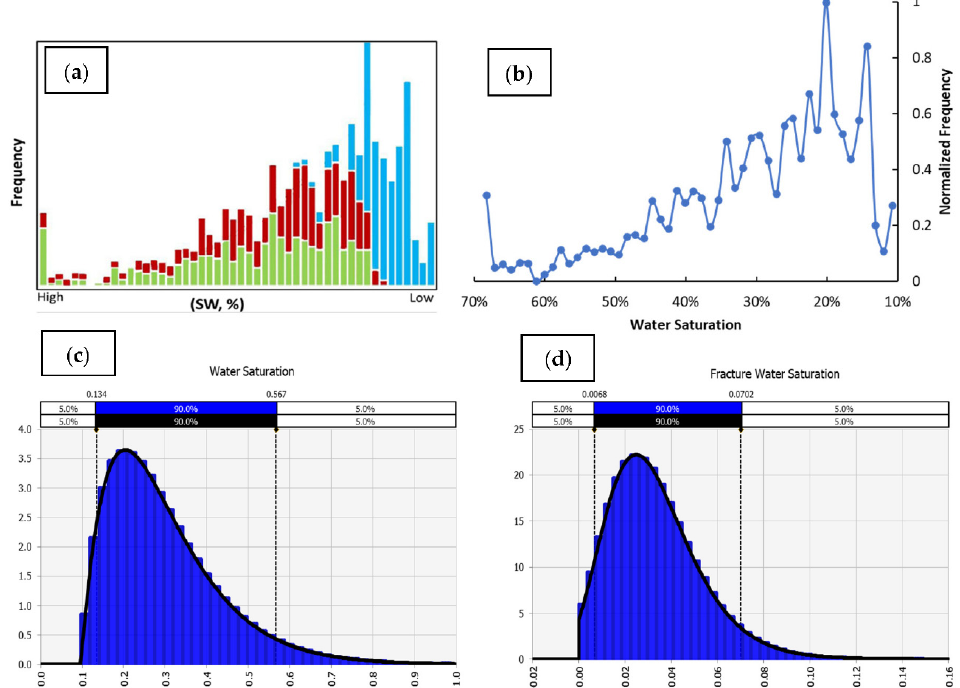
Figure 7. ( a ) Qualitatively scaled water saturation distribution of Jafurah basin (after Hakimi et al. [17,18]. ( b ) Normalized frequency obtained by digitization of plotted with the midpoint of each histogram porosity column. ( c ) Distribution of formation water saturation. ( d ) Distribution of fracture water saturation.